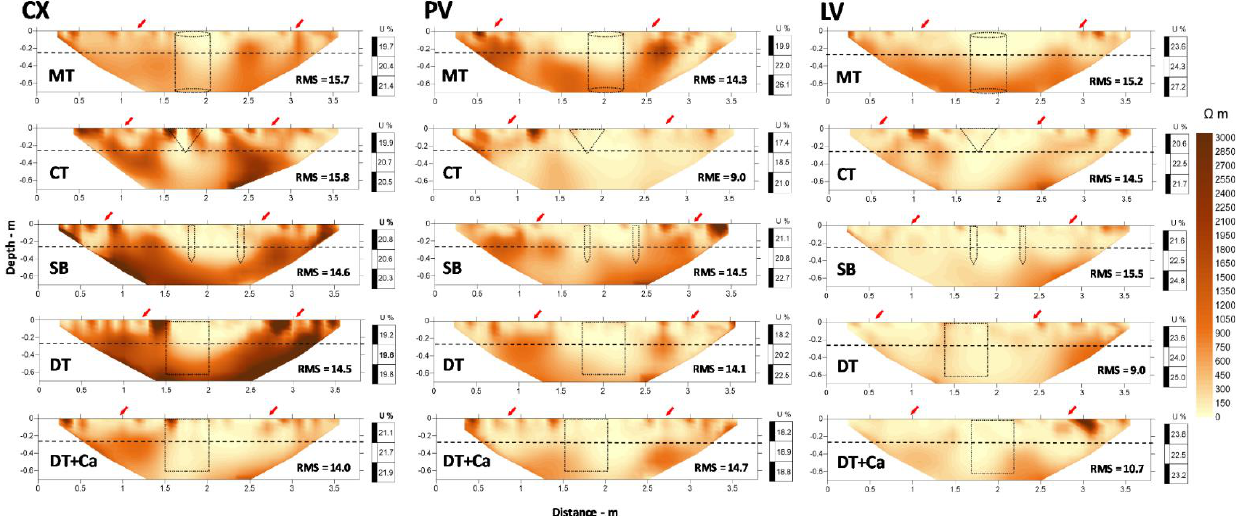
Figure 2. 2D maps of soil electrical resistivity for three soil classes (CX, PV, and LV) under five different soil tillage treatments [MT: minimum tillage with a pit (0.4 m in diameter by 0.7 m deep); CT: conventional tillage (0.25 m deep); SB: subsoiler with booted ripper points on two shanks (0.45 m deep); DT: deep mixing tillage with rotary hoe tiller (0.5 wide by 0.6 m deep); DT + Ca: deep mixing tillage with rotary hoe tiller (0.5 wide by 0.6 m deep) + additional liming. The horizontal dashed line demarcates the working depth of the plow (approximately 0.25 m); dotted lines project the working area of the implements used in each tillage treatment; U soil moisture based on the weight (U, %) of each layer at the time of data collection. Measurements were performed eight months after tillage operations.